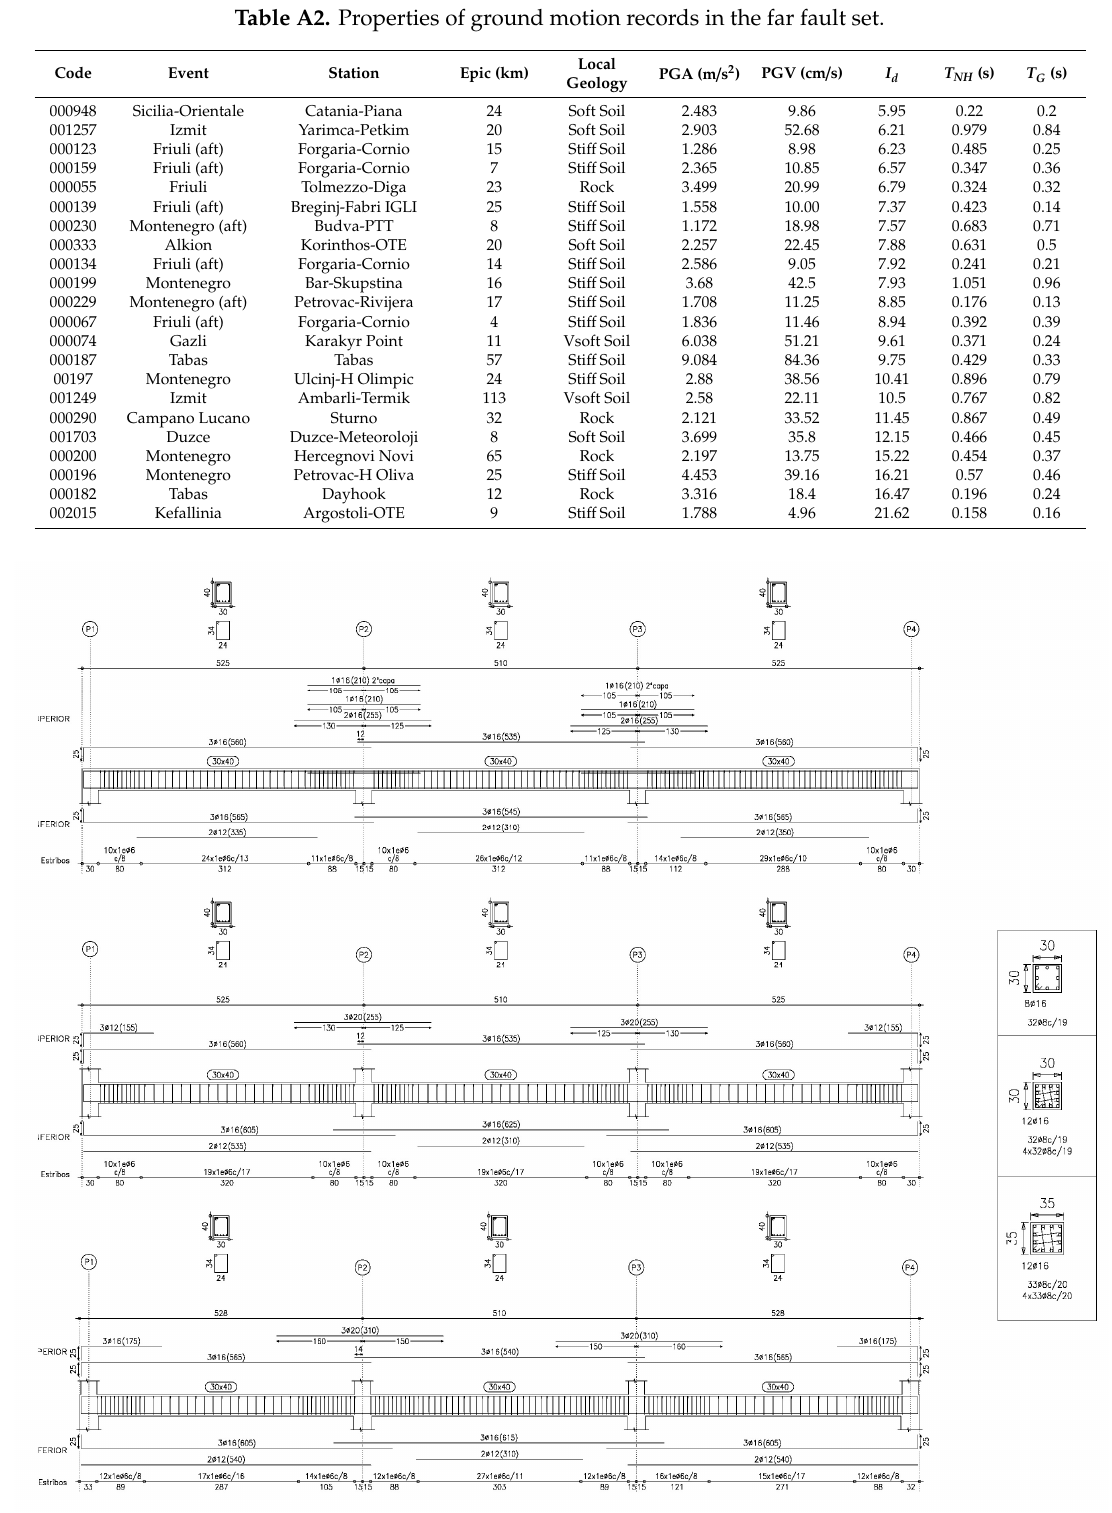
Figure A1. Dimensions and reinforcement for the 3-storey frames.